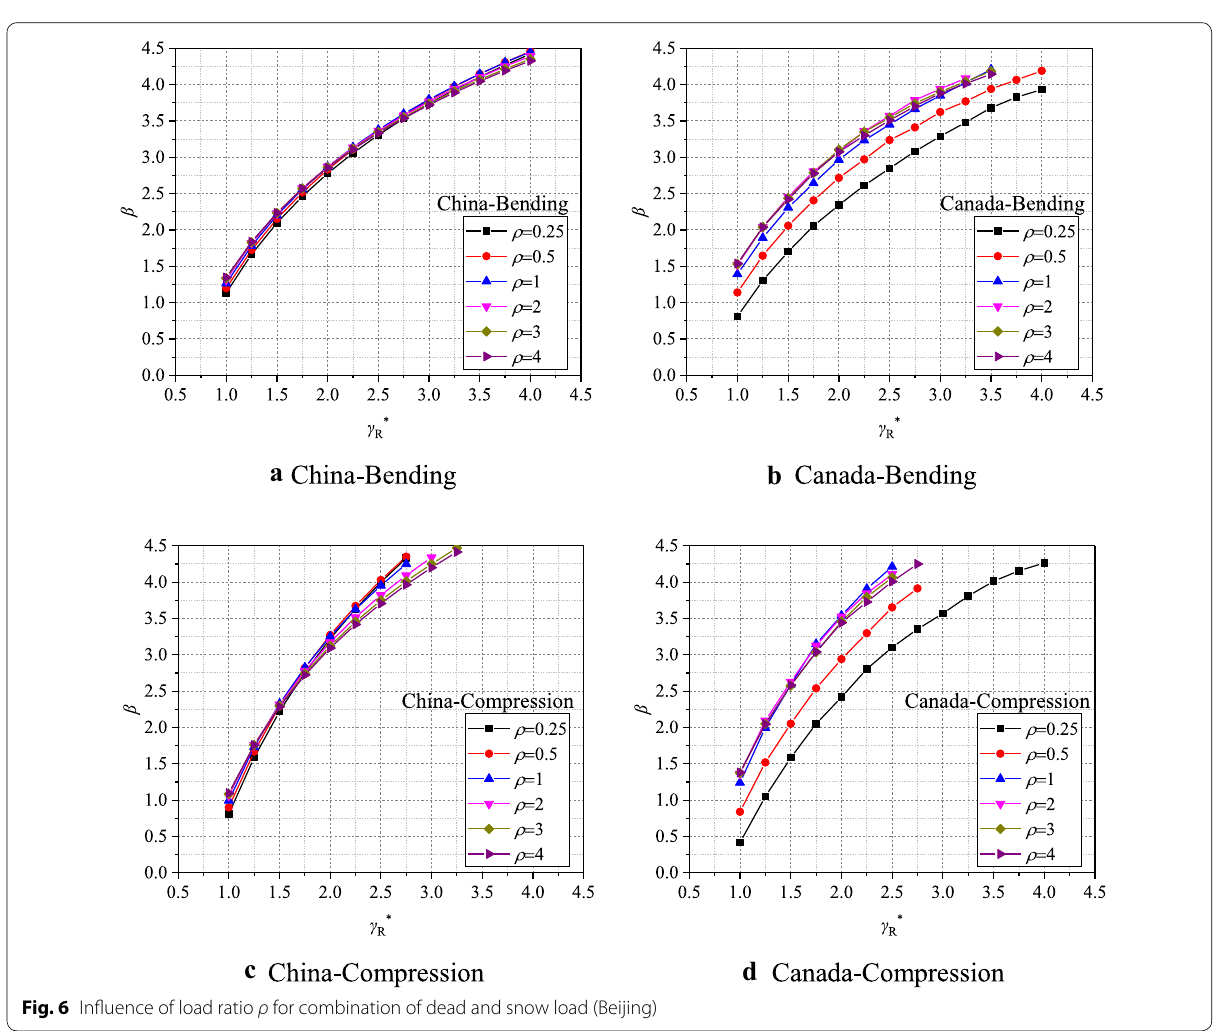
Fig. 6 Influence of load ratio ρ for combination of dead and snow load (Beijing)